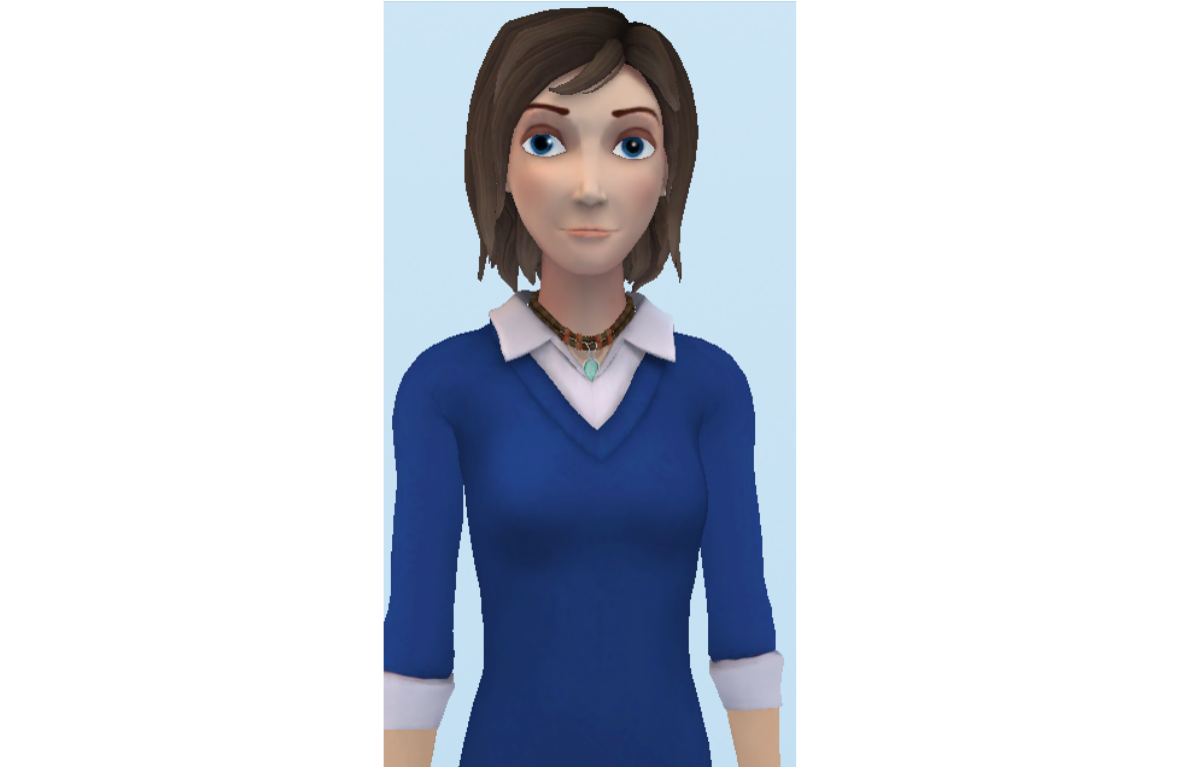
Figure 1. Embodied conversational agent